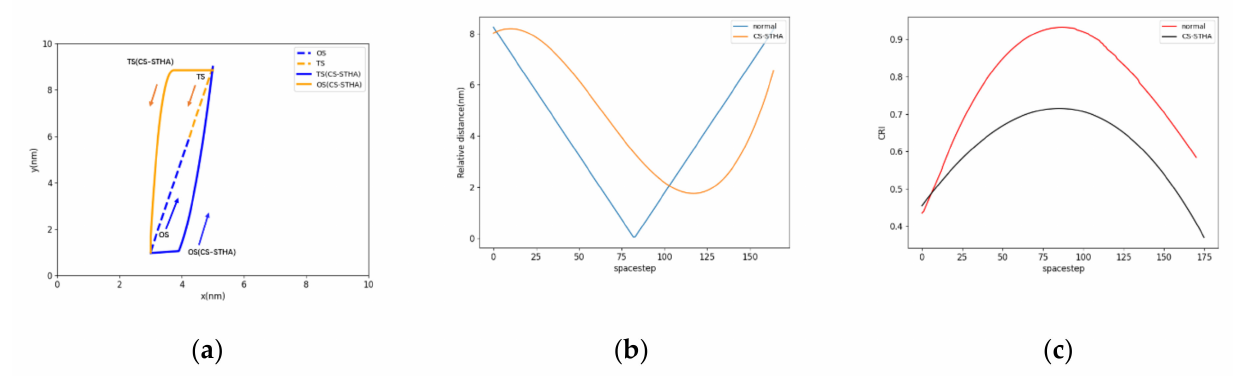
Figure 10. The result of the head-on encounter between the two ships. ( a ) trajectories; ( b ) relative distance; ( c ) CRI.